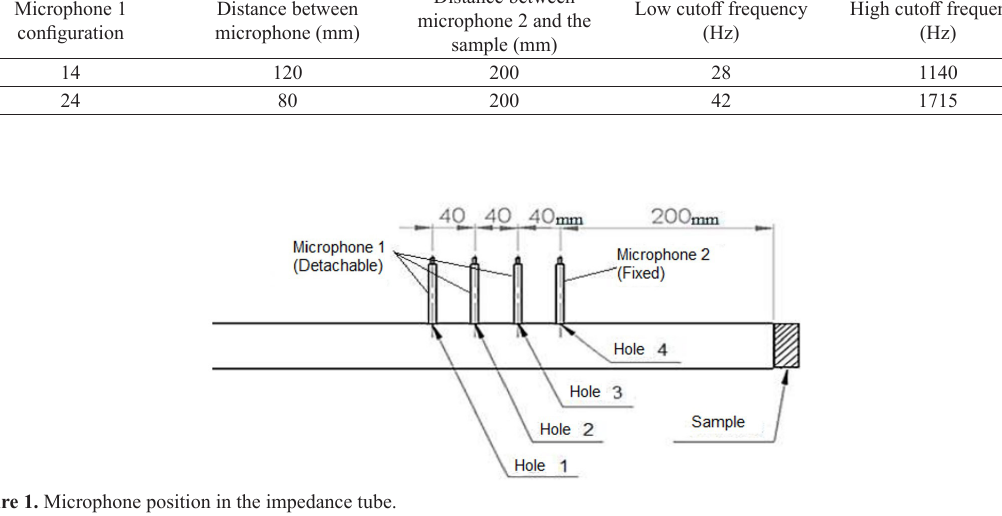
Table 2. Microphone configurations. Microphone 1 configuration